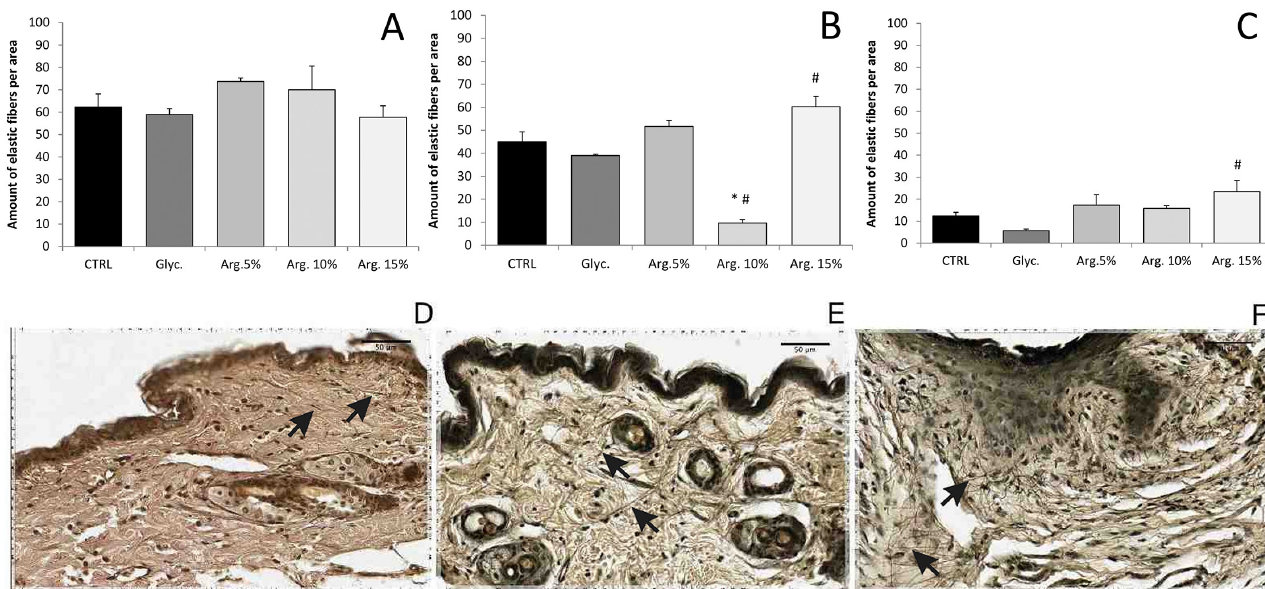
FIGURE 5 - Quantitative analysis of elastic fibers in female mouse skin. Mice from group 1 (A), group 2 (B), and group 3 (C) were treated with vehicle (Glyc.), L-arginine at 5% (Arg. 5%), 10% (Arg. 10%), or 15% (Arg. 15%), or did not receive any treatment (CTRL). P < 0.05, * versus CTRL, # versus Glyc.; (3 ≤ n ≤ 5). (D–F) show the photomicrographs (x400) of the skin sections stained for evidence of elastic fibers using the Verhoeff method: (D), mice from group 3, CTRL; (E), mice from group 3 treated with L-arginine at 15%; and (F), mice from group 1 treated with L-arginine at 10%.